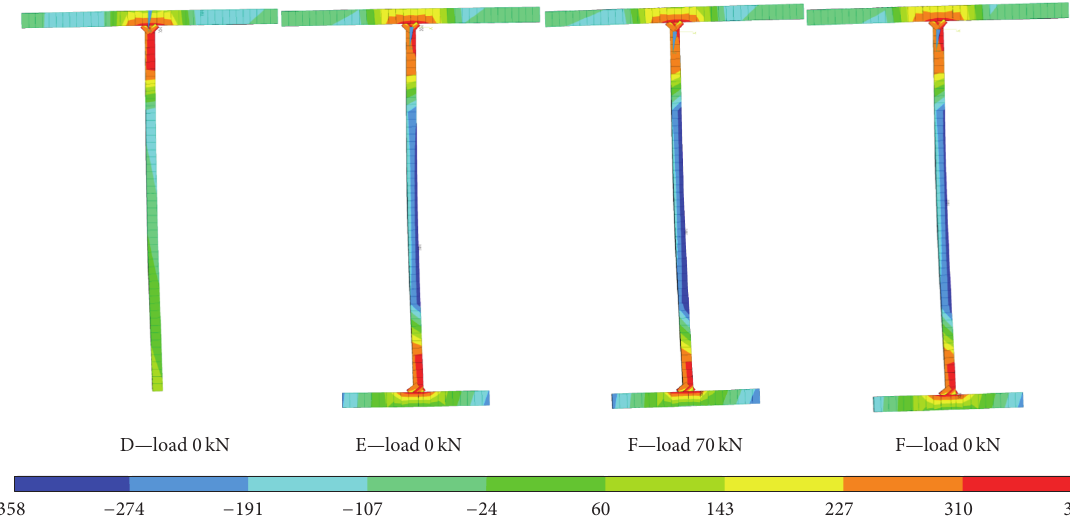
Figure 9: Residual stresses in the longitudinal direction 𝜎 𝑥 [MPa] caused by welding at midheight.